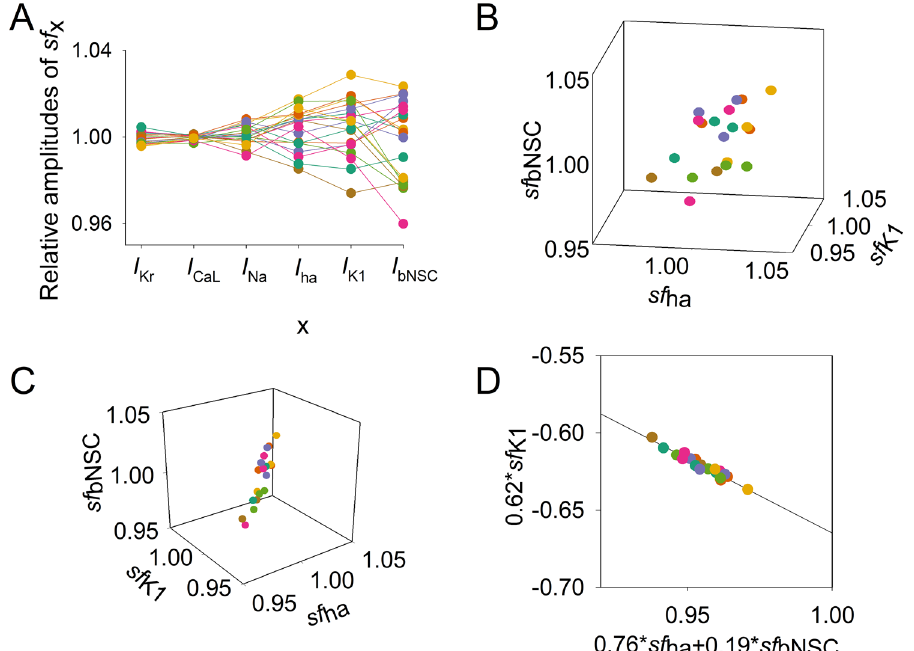
Figure 5. Distribution of sf x in the top 20 sets of sf x s obtained from the multi-run orp test in Cell86 in Fig. 2. Data points of normalized sf x in each set are depicted in different colors. ( A ) Plot of the amplitudes of each sf x (indicated on the abscissa). ( B ) Three-dimensional plot of the three parameters of sf ha , sf K1, and sf bNSC . ( C ) A different solid angle view of the three-dimensional plot showing a linear correlation; see text for the plot in ( D